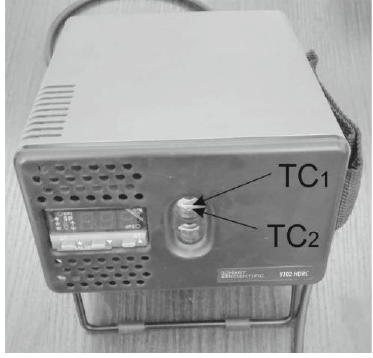
Fig. 5. A view of an instrument for calibration of thermocouples (a calibrator) with marked TC 1 and TC 2 input.